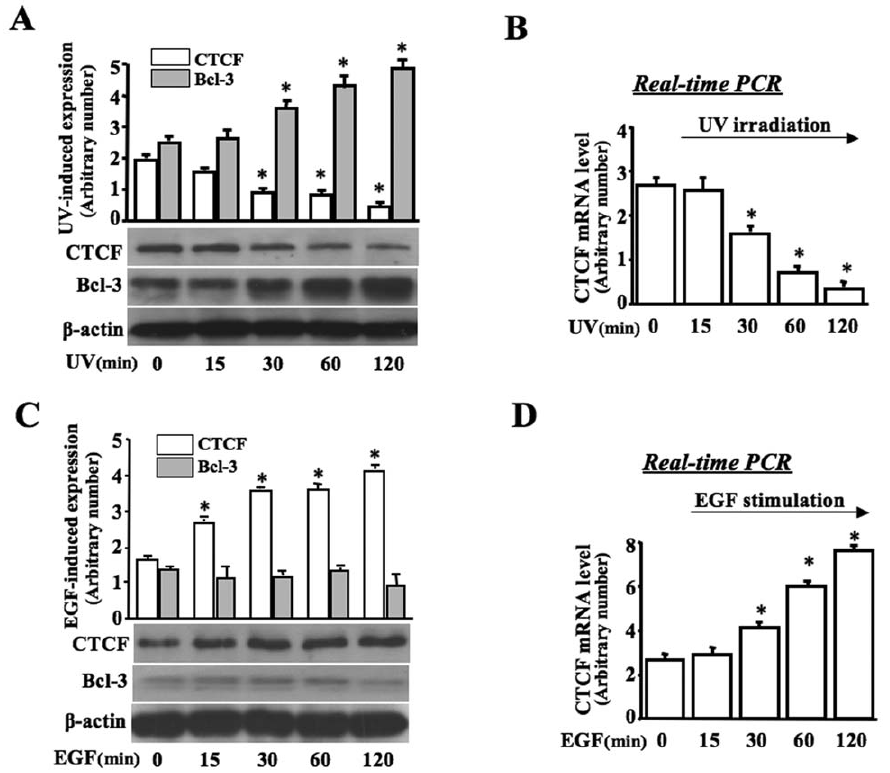
Figure 2. Effect of EGF and UV stress on CTCF activity. (A) Time course of UV stress-induced changes in Bcl-3 and CTCF activity. (B) Quantitative detection of UV stress-induced effect on CTCF mRNA expression by real time PCR. (C) Effect of EGF on Bcl-3 and CTCF activity following a time course. (D) Quantitative detection of EGF-induced effect on CTCF mRNA expression by real time PCR. Proteins and RNA were isolated from HCE cells at indicated time-point before/after EGF (20 ng/ml) and UV irradiation (42 m J/cm 2 ), respectively. Symbol ‘‘*’’ indicates significant differences between control and UV stress-induced cells ( p , 0.05, n=3).